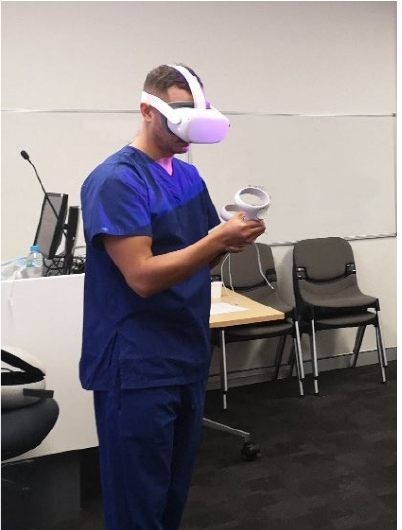
Figure 1. One of the participants assessed the VR heart models using Oculus Quest 2 (Facebook Technologies, LLC, Irvine, California, United States). He was able to interact with the VR heart models using hand-held controllers.